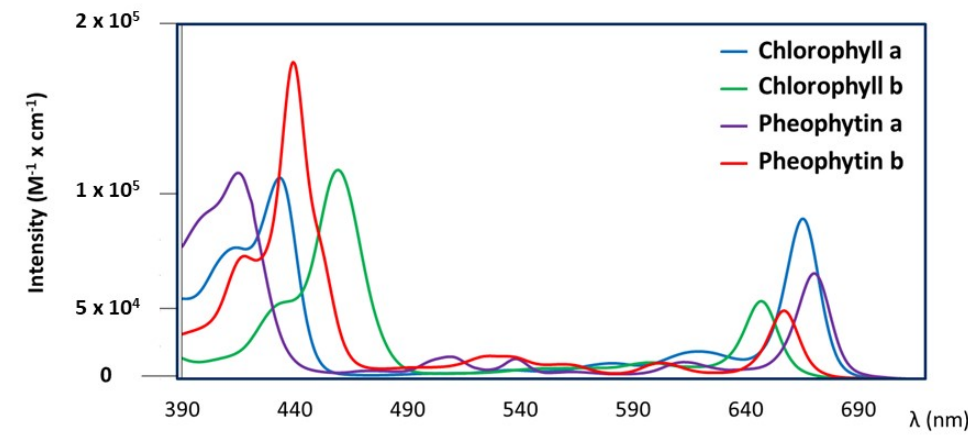
Figure 2. Molar extinction coefficients, ε i ( λ ), of four pigments diluted in triolein: chlorophyll a, chlorophyll b, pheophytin a, and pheophytin b.